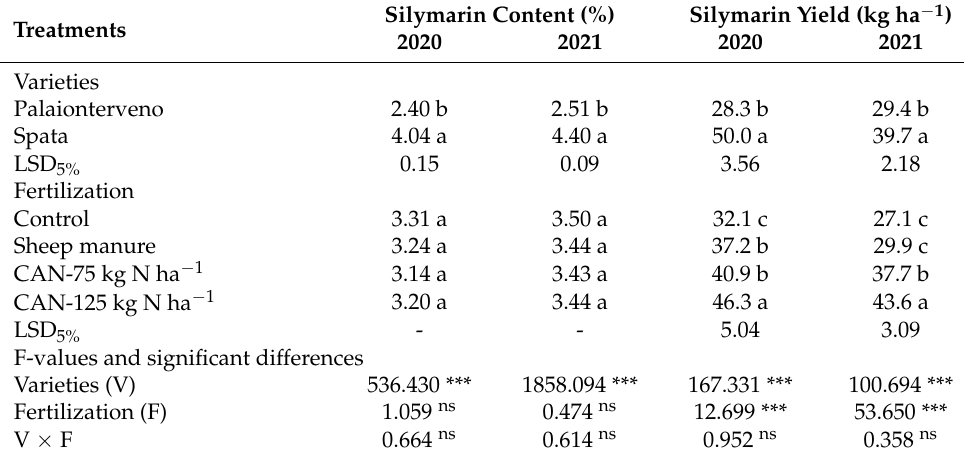
Table 8. Effects of two milk thistle varieties (Palaionterveno and Spata) and fertilization regimes (sheep manure and inorganic fertilizer) on silymarin content and yield of milk thistle.